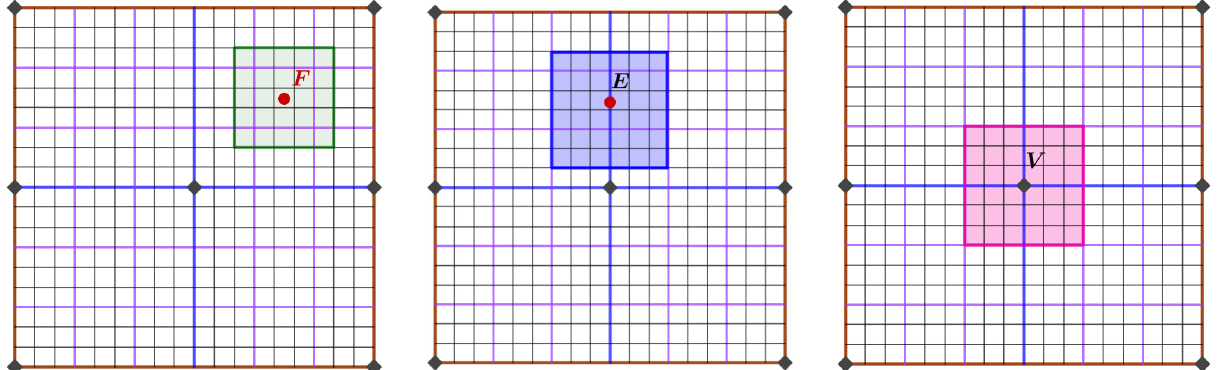
Figure 7. Three different types of regions. Left: the region surrounding the face point. Middle: the region surrounding the edge point. Right: the region surrounding the vertex.